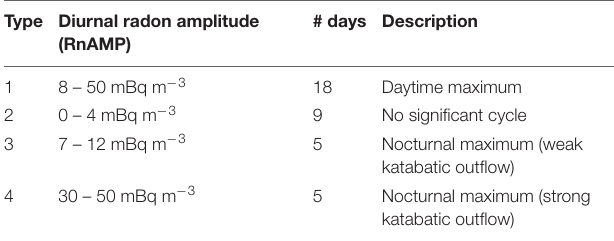
TABLE 2 | Daily summary of MBL radon concentration characteristics observed from the RV Investigator between 20-January and 25-February 2017. Type Diurnal radon amplitude